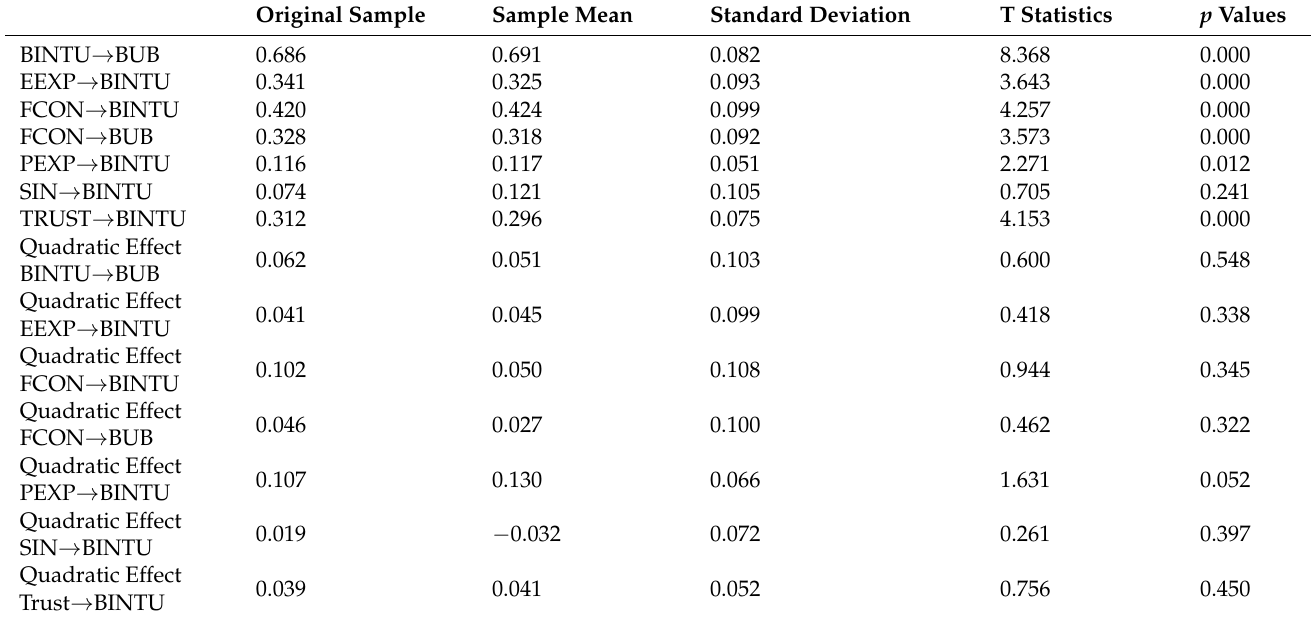
Table 12. The absence of non-linearity (quadratic effect)